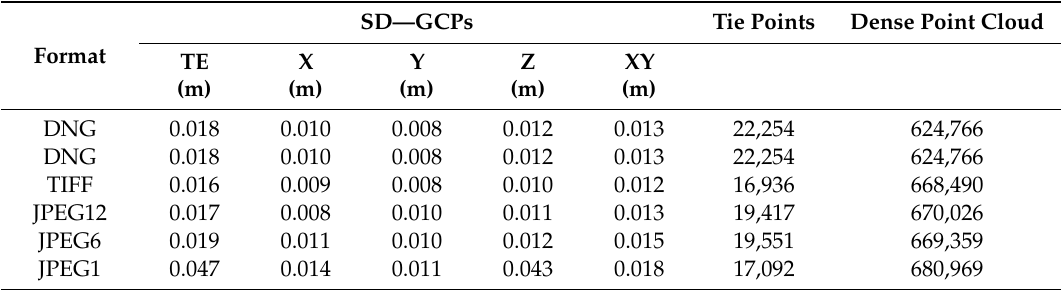
Table 10. Evaluation of the accuracy using 3DF Zephir on GCPs and number of tie points—Test site